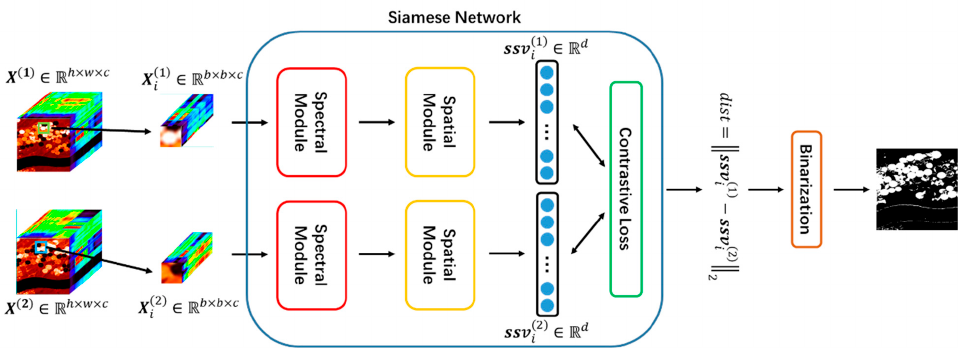
Figure 2. Overview of the spectral-spatial convolution neural network with Siamese architecture (SSCNN-S).